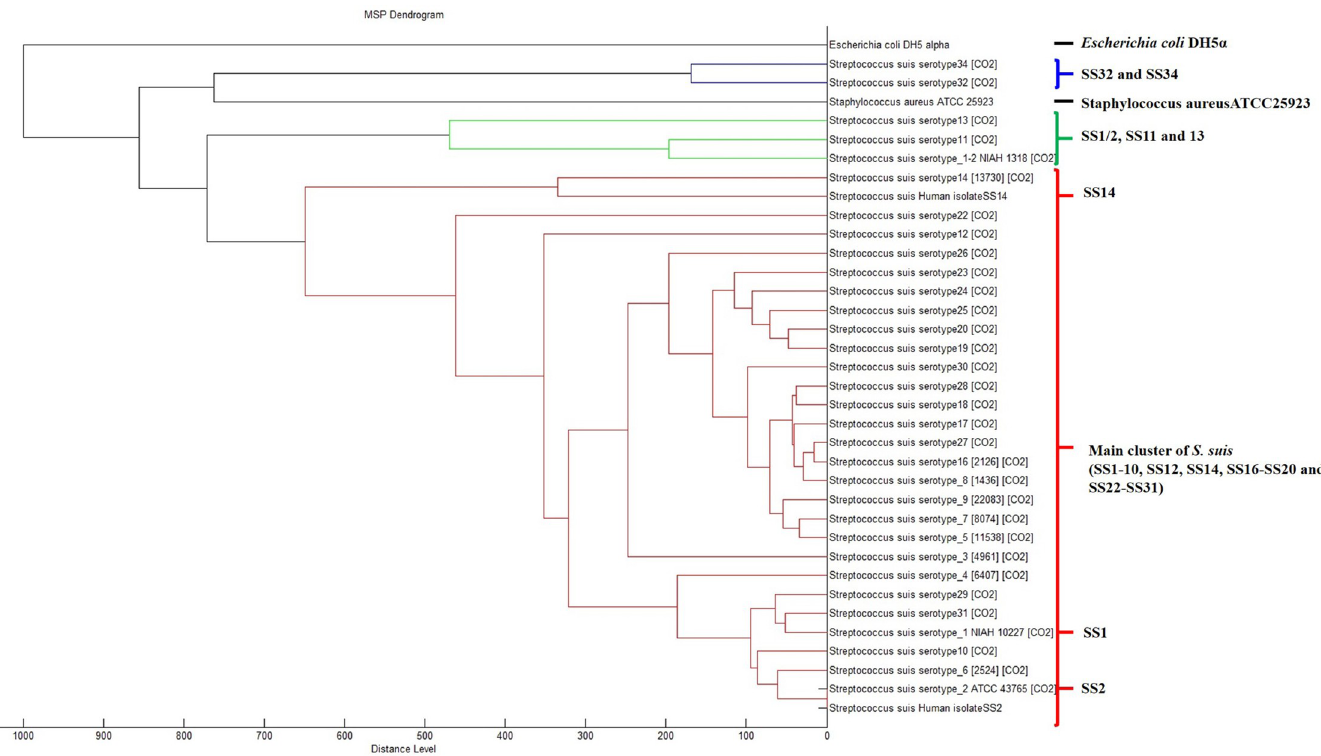
Fig 2. Dendrogram based on the PMFs of reference SS1/2, SS1-14, SS16-20, SS22-32, SS34, and SS1/2 grown anaerobically. SS32 and SS34 clustered in a group, while SS1/2, SS11, and SS13 clustered in another group and closer to the main SS PMFs. Staphylococcus aureus ATCC 25923 and E. coli DH5 alpha were included as the out group.